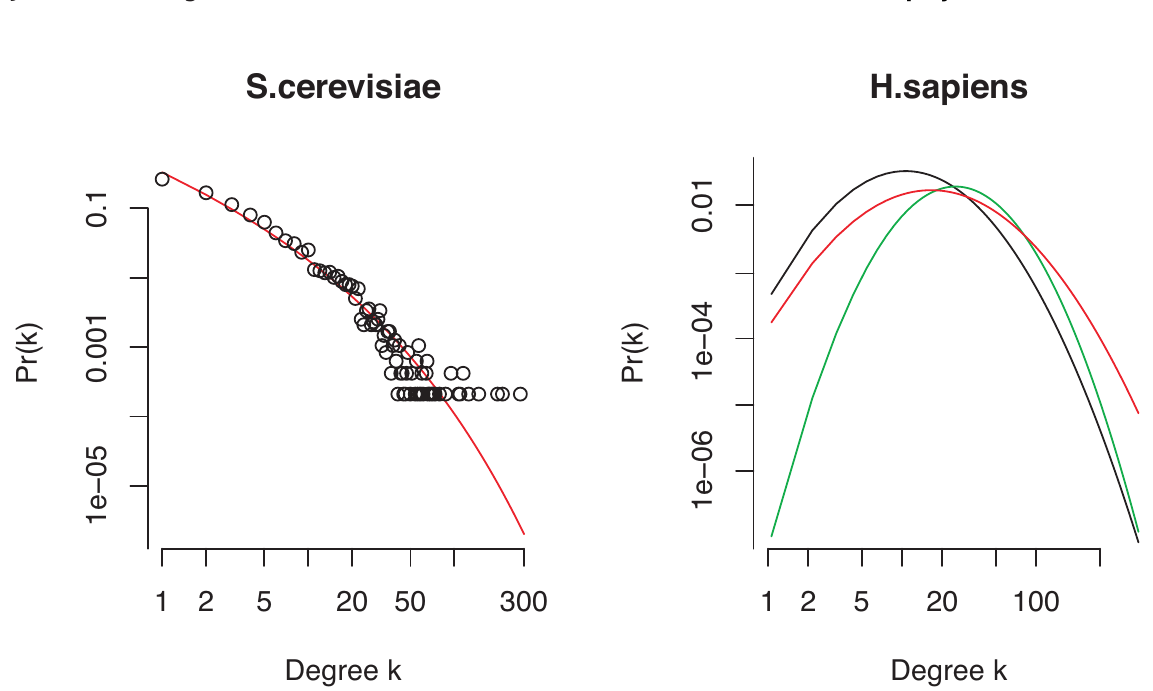
Figure 3: Empirical degree distribution of present yeast PIN dataset (black circles) and estimated degree distribution for the full yeast PIN. The three human estimates correspond to the datasets of Stelzl [26] (black), Rual [24] (red) and DIP (green); Individual human datasets were downl oaded from the IntAct database ( www.ebi.ac.uk/intact